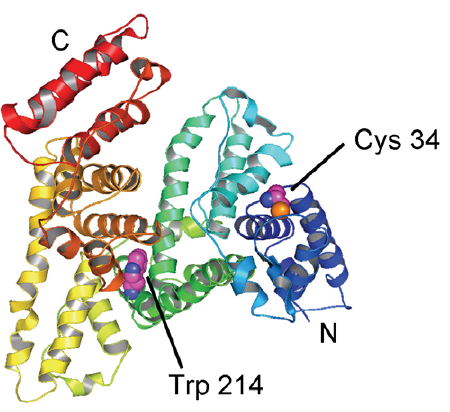
Figure 6. Overview of human serum albumin (HSA). The protein secondary structure is shown schematically and the domains are colored-coded as follows: I, blue; II, green; III, yellow; IV, red. Cys-34 and Trp-214 are shown in a space-filling representation and colored by atom types (PDB ID: 1E78; [45]).